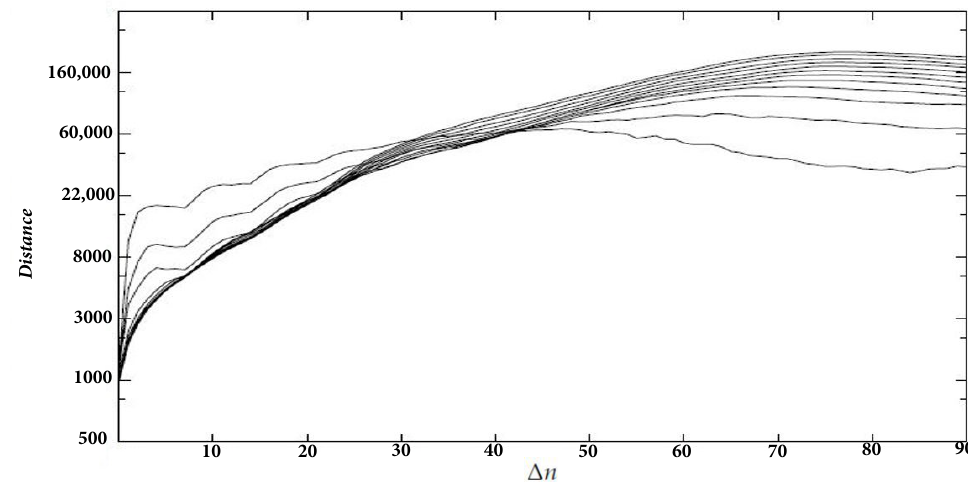
Figure 7. e S ( ∆ n ) for coop1 ( ε = 2500).